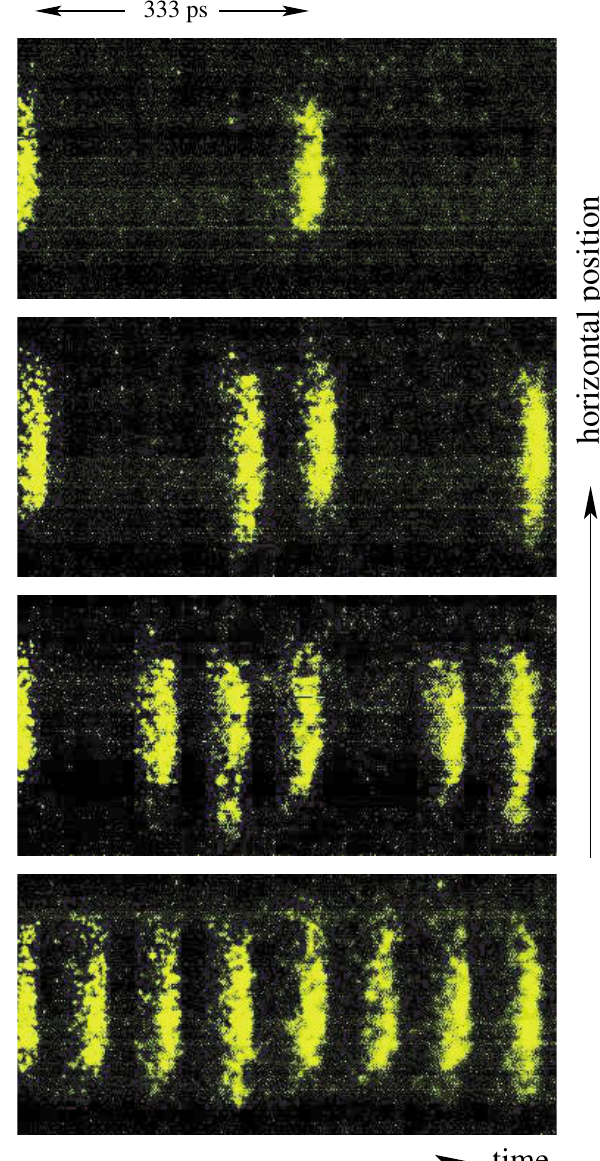
FIG. 20. (Color) Bunch train combination with a factor 4, as observed with a streak camera. The horizontal axis represents time; the vertical axis corresponds to the horizontal position. The images from top to bottom are taken over four consecutive turns.